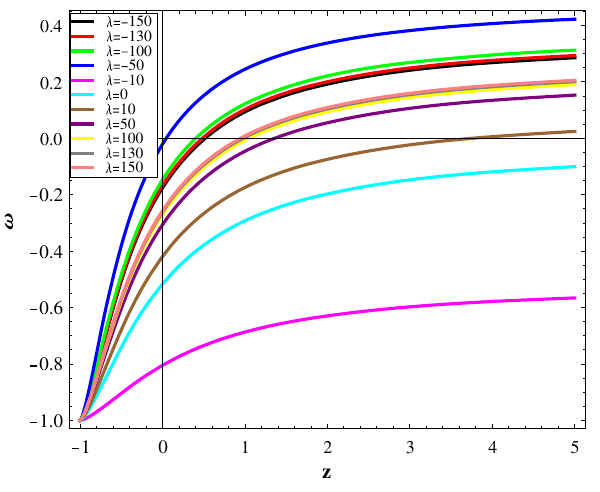
Fig. 2 The plot of ω vs. z for n = 1 .